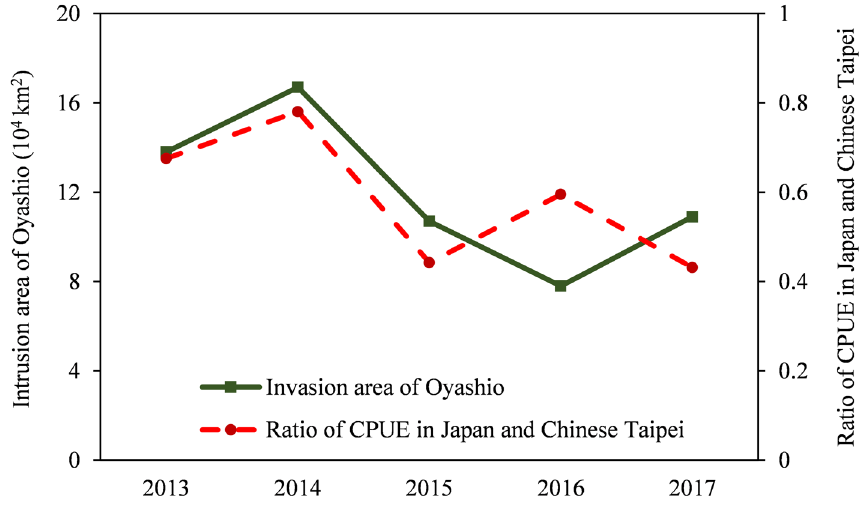
Figure 11. Variations in the intrusion area of the Oyashio and the relative abundance variation